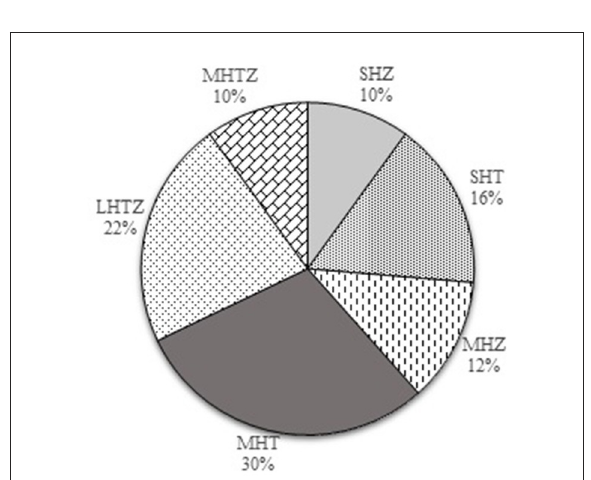
FIGURE3 Proportion of different peri-urban dairy farm types in the study area in South Benin; SHZ, small herds of zebu (Yakana) farms; SHT, small herds of taurine (Boboji) farms; MHZ, medium herds of zebu (Yakana) farms; MHT, medium herds of taurine (Boboji) farms; LHTZ, large herds of taurine (Boboji) and zebu (Yakana) farms; MHTZ, medium herds of zebu Goudali mixed with taurine (Boboji) and/or zebu Yakana